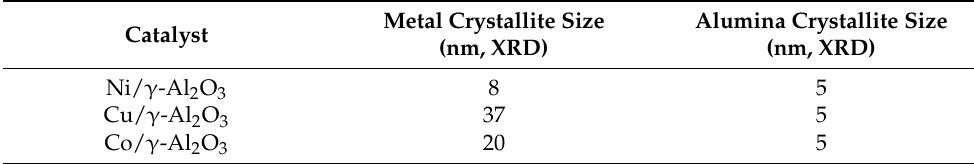
Table 7. The results of XRD analyses of all three tested